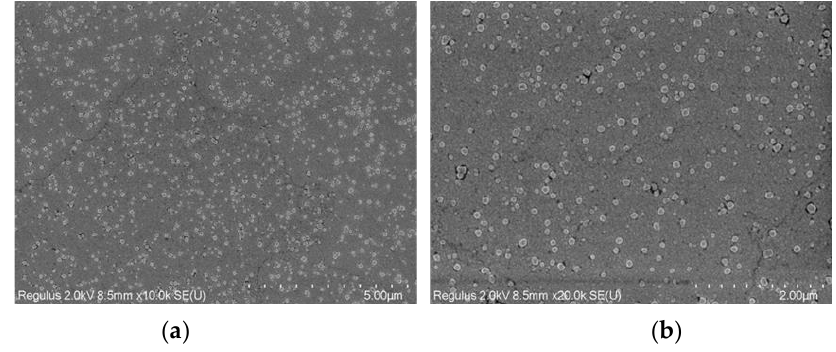
Figure 4. ESEM images of CFEO-Ms at magnification of ( a ) 10,000× and ( b ) 20,000×.